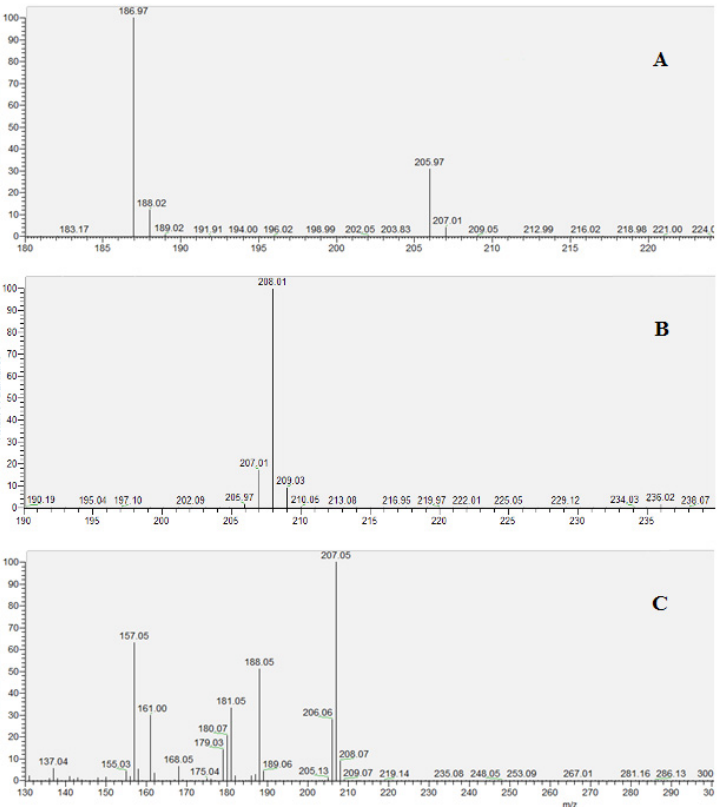
Figure 2. Mass spectra of the cyanide derivative PFB-CN in cyanide spiked blood samples, obtained with the following ionization techniques: ( A ) NCI, ( B ) PCI, ( C ) EI